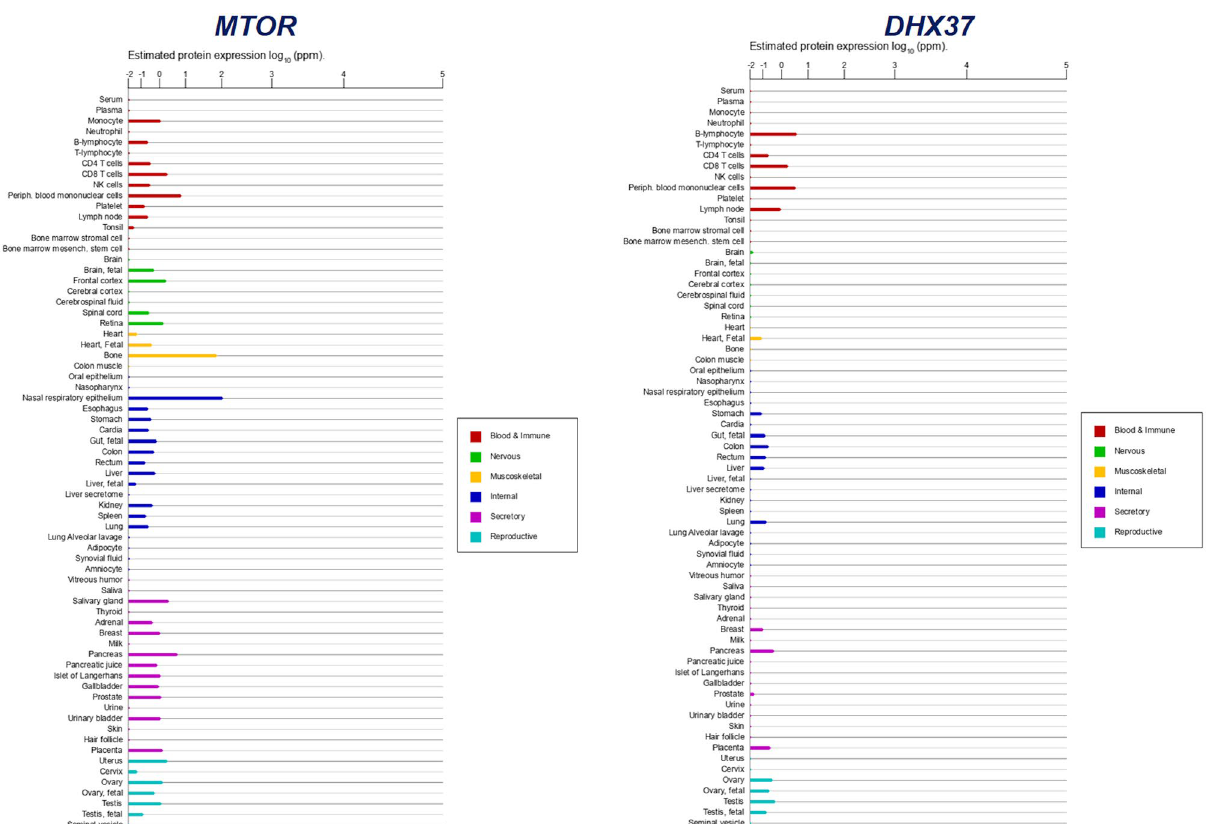
Figure 4. The protein expression levels in normal tissues and cell lines from ProteomicsDB, MaxQB, and MOPED for MTOR and DHX37 genes. The results showed that the genes have a high level of protein expression in both blood and immune